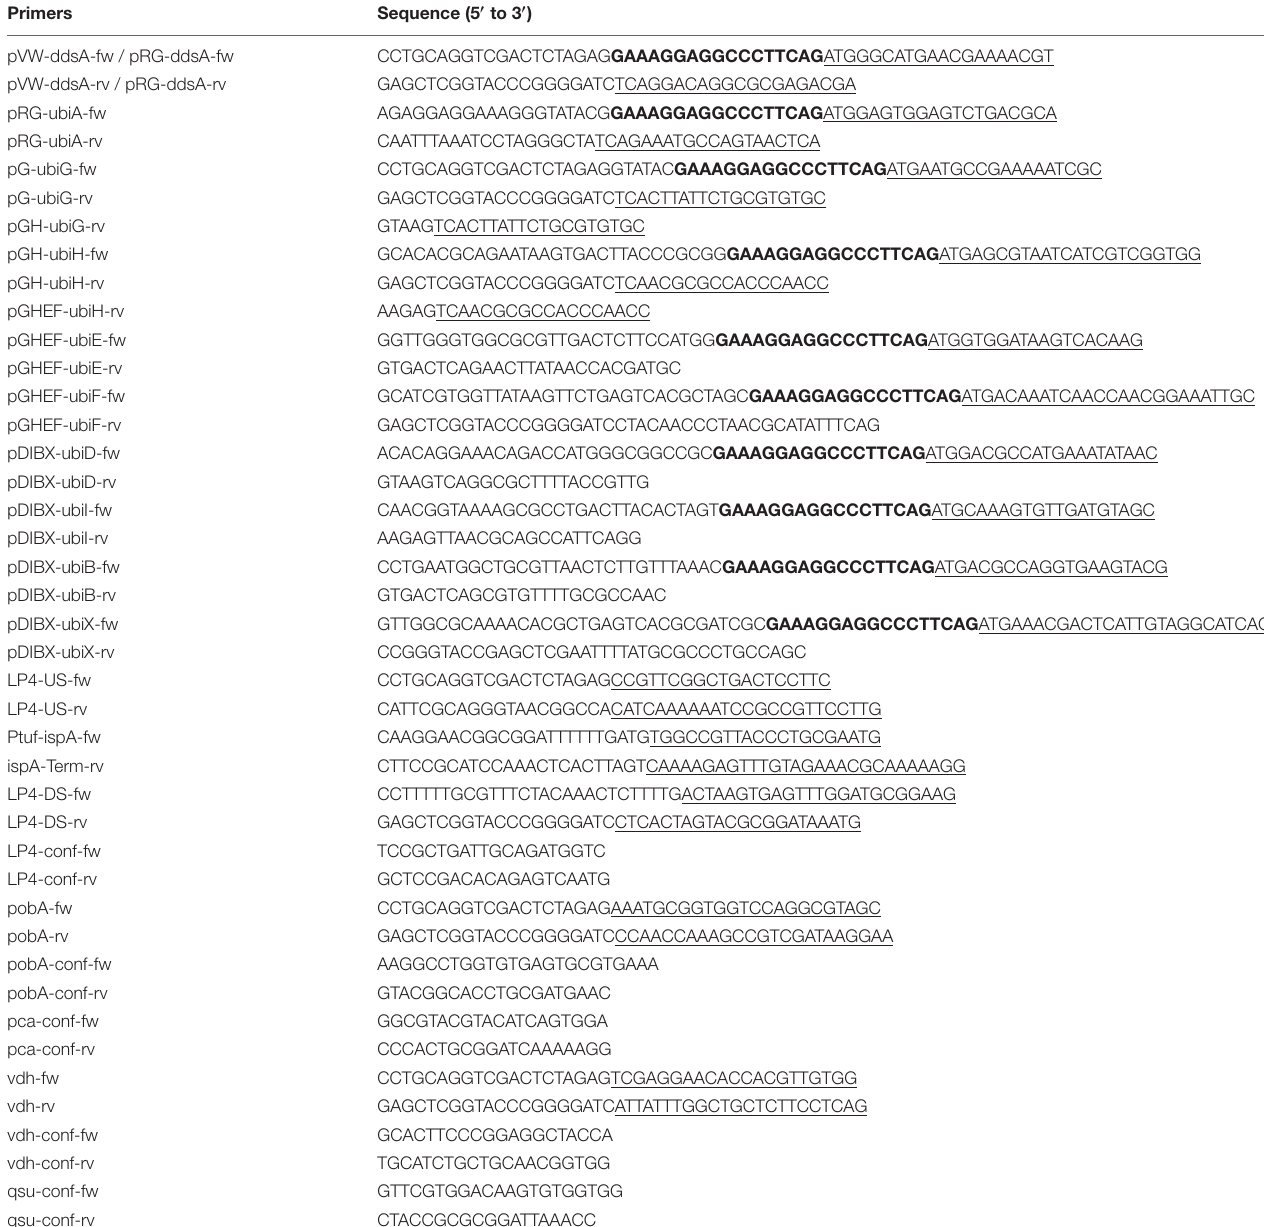
TABLE 3 | Primers used in this work. Primers Sequence (5 (cid:48) to 3 (cid:48)